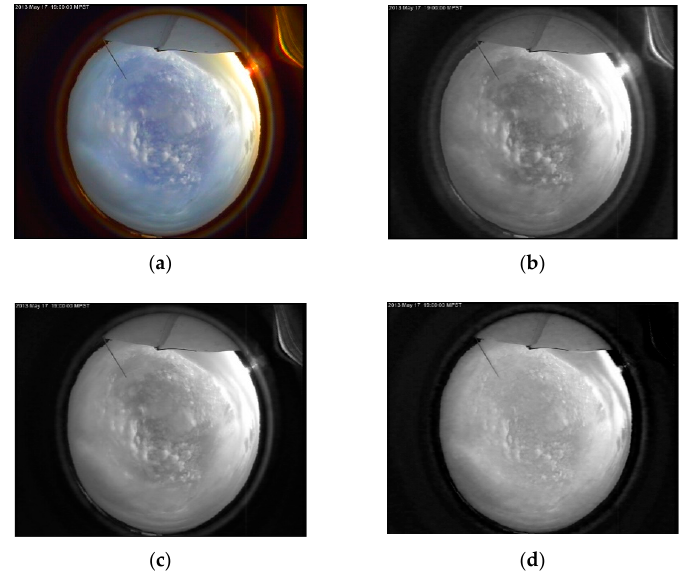
Figure 3. A raw all-sky image taken by the all-sky imager at PERMATApintar Observatory ( a ). The following three images are the red ( b ), green ( c ) and blue ( d ) color channels split of the raw all-sky image.